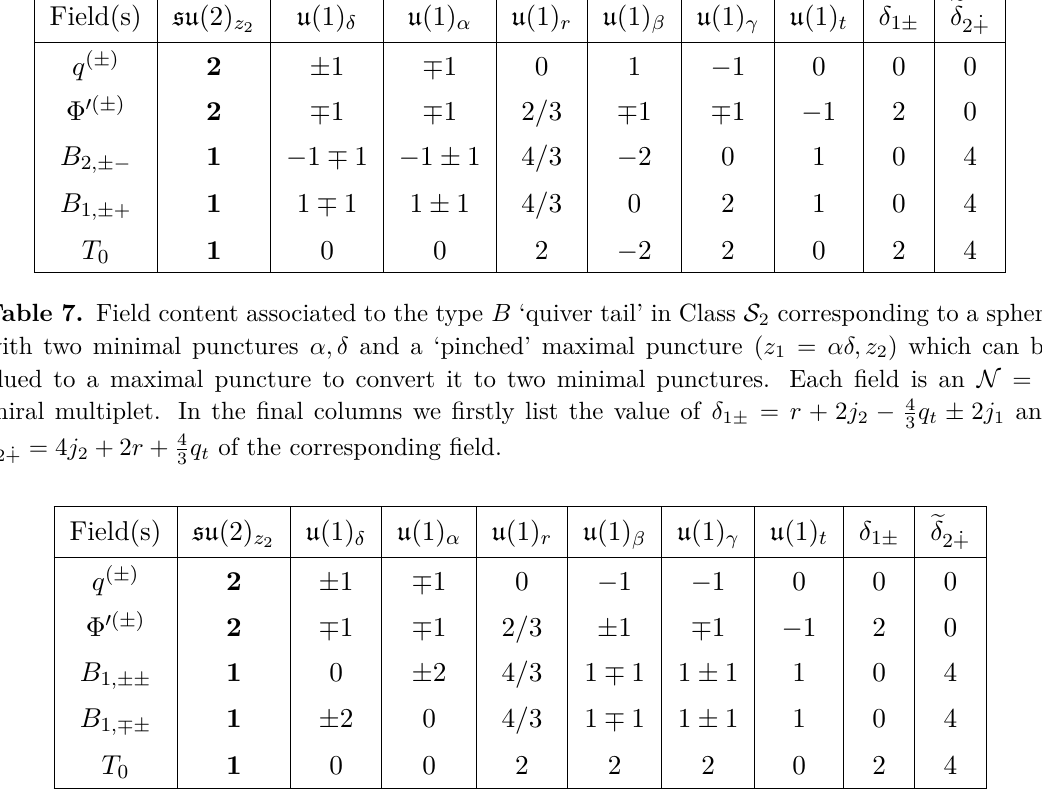
= αδ, z ) which can be 1 2 = r + 2 j 4 q t ± 2 j 1 and 1 ± 2 − 3